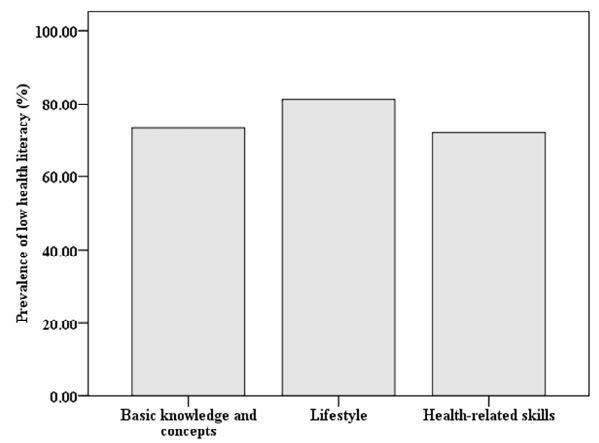
Figure 3. Prevalence of low health literacy measured by three subscales: basic knowledge and concepts, lifestyle, and health-related skills.